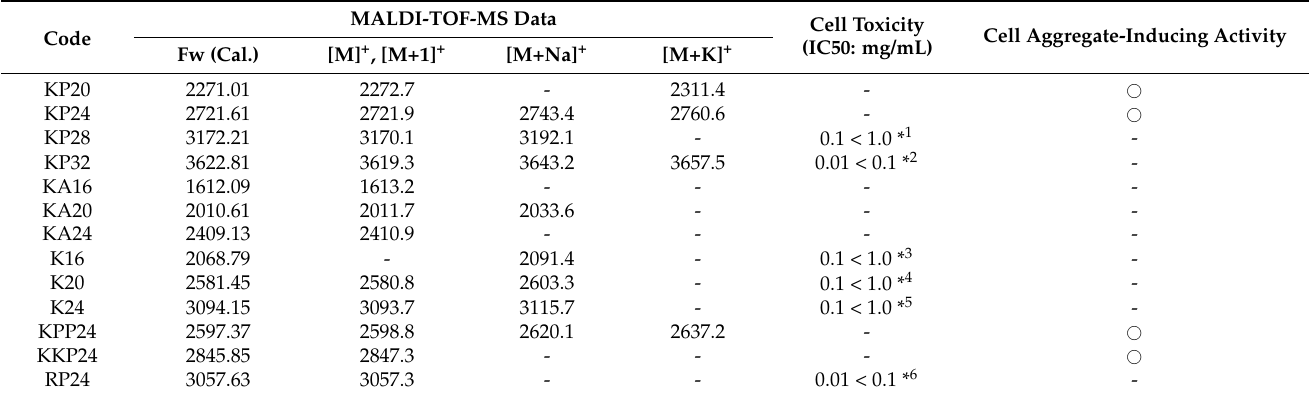
Table 2. Results of peptide synthesis and bioactivity of designed